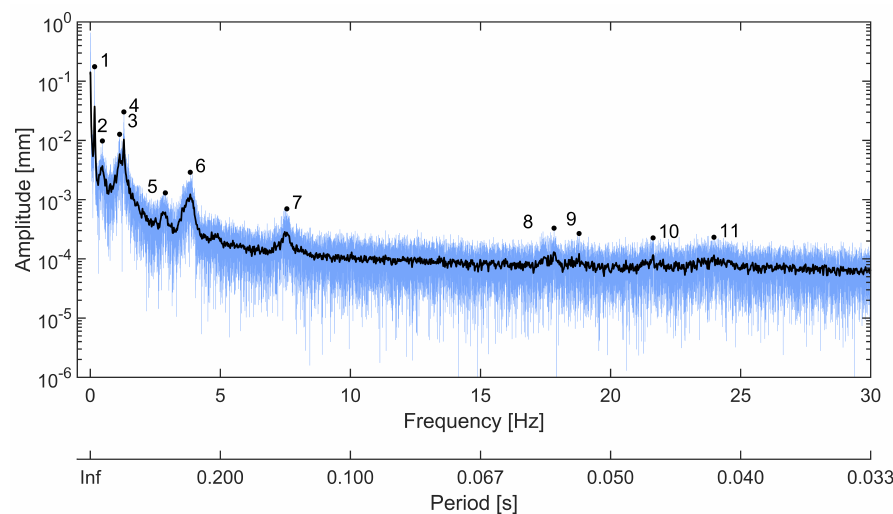
at a height of 9m above the ground as X G